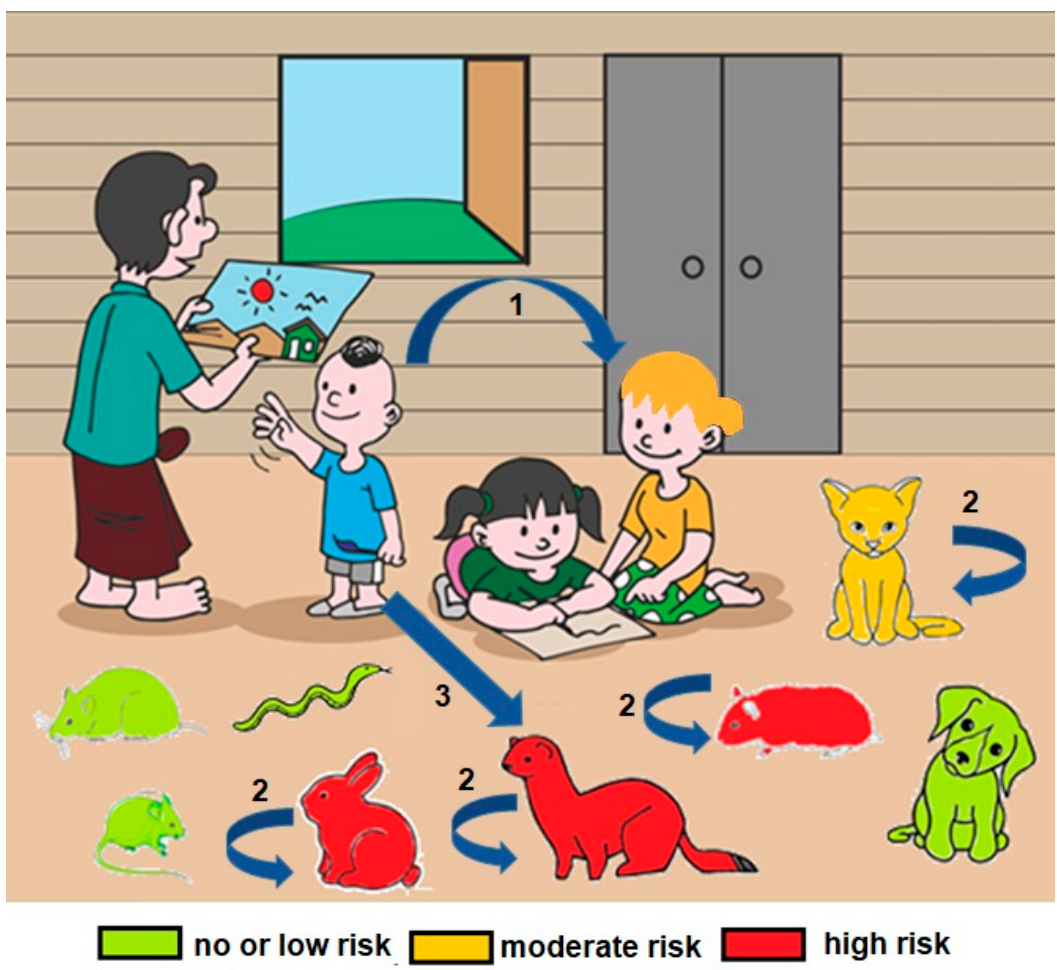
Figure 1. SARS-CoV-2 zoonotic risk associated with exposure to pets. The susceptibility of pets to SARS-CoV-2 infection, and therefore the potential risk of transmission of this virus from these animals to humans, can be evaluated as nul or low (green animals), medium (yellow) or high (red). The arrows and numbers indicate the currently demonstrated transmission chain of SARS-CoV-2: (1) from human-to-human; (2) from animal-to-animal within a specific animal species (cats, hamsters, and ferrets); and (3) from human-to-animal (cats and